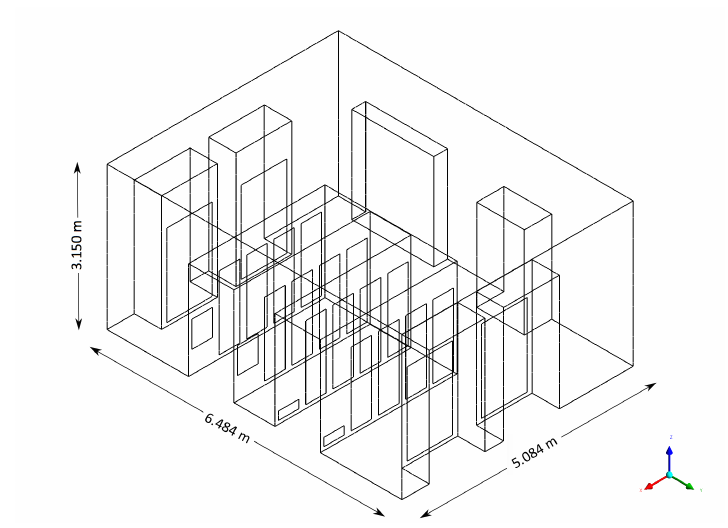
Figure 1. Geometry of the data center in the CFD model.